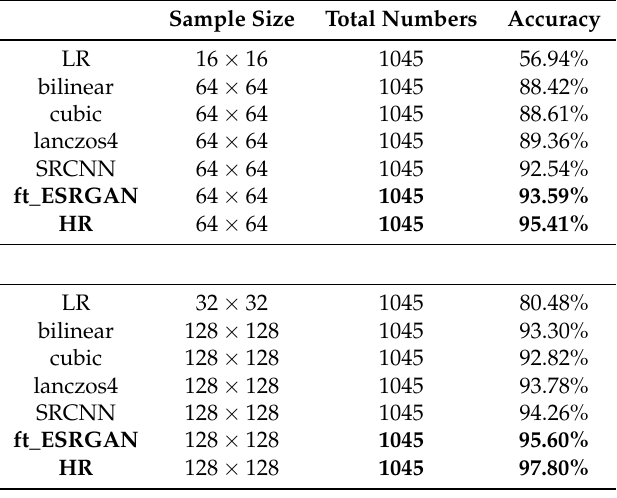
Table 3. Comparison of classification results for low-resolution (LR) and SR images based on 6 categories.